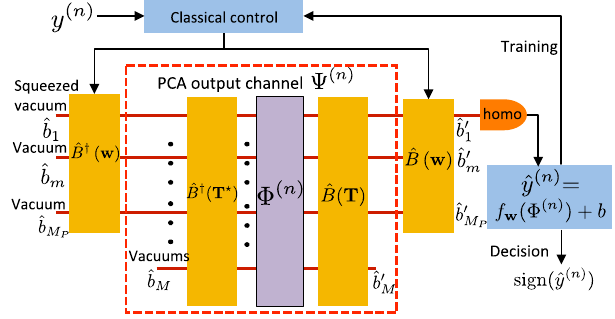
FIG. 6. A combined scheme with entanglement-assisted SVM and PCA. Using multipartite-entangled probe states, the PCA is trained to reduce the original M -mode quantum channel Φ ð n Þ (purple rectangle) to an M -mode quantum channel Ψ ð n Þ (red P dashed box), which is, in turn, used by the entanglement-assisted SVM to carry out data classification